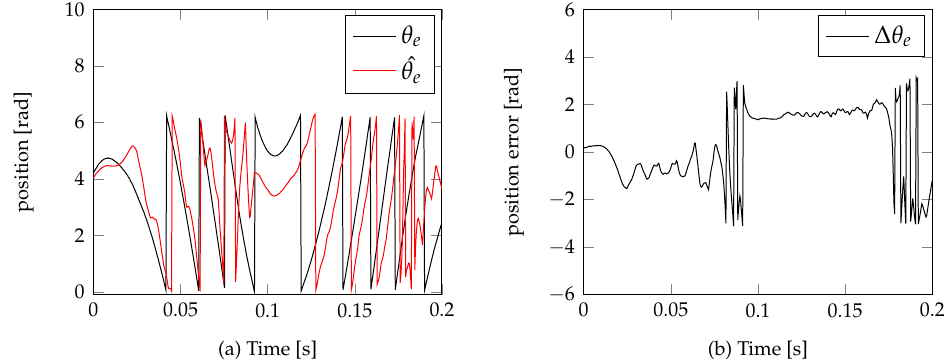
Figure 11. Synchronization lost at: f b = 384 Hz, f s = 5 kHz and reference speed w eref = 400 rad/s. ( a ) measured ( θ e ) and estimated ( ˆ θ e ) rotor positions, ( b ) estimated position error ( ∆ θ e